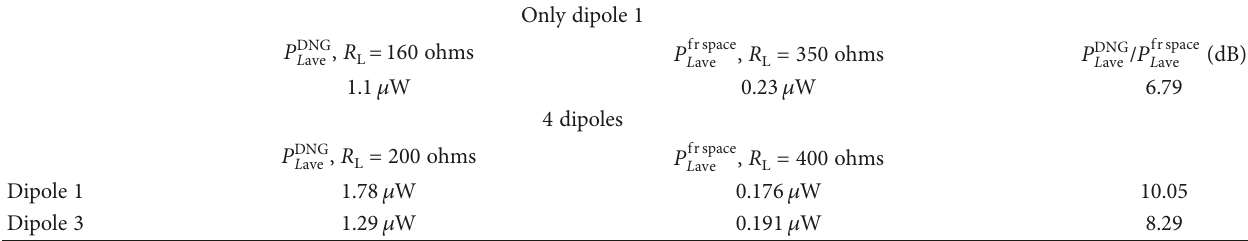
fi er. L at the output of the recti